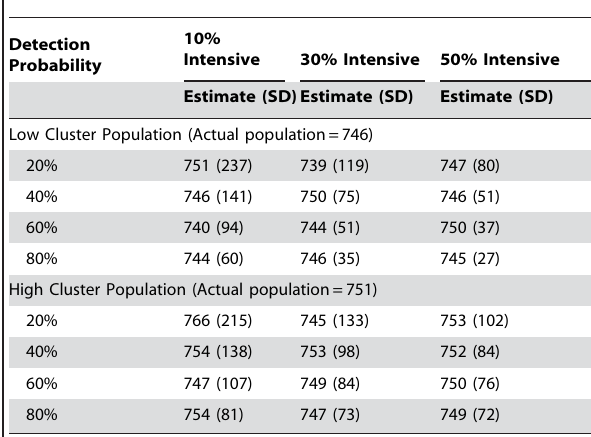
Table 2. Median population estimates (SD) for the double sampling